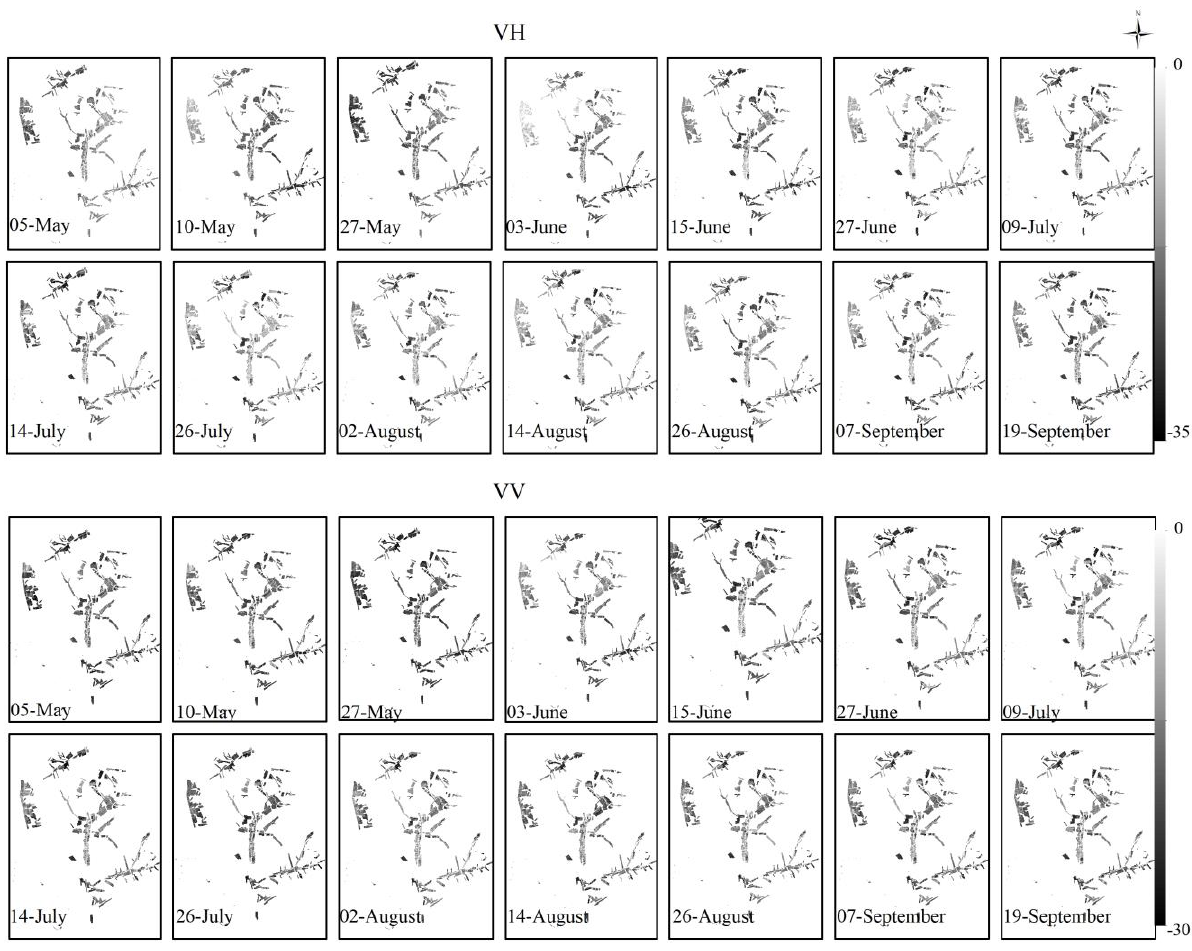
Figure 4. Spatial distribution of VH/VV in Bornuur soum of Tuv province using Sentinel-1 with crop growing season of 2019.